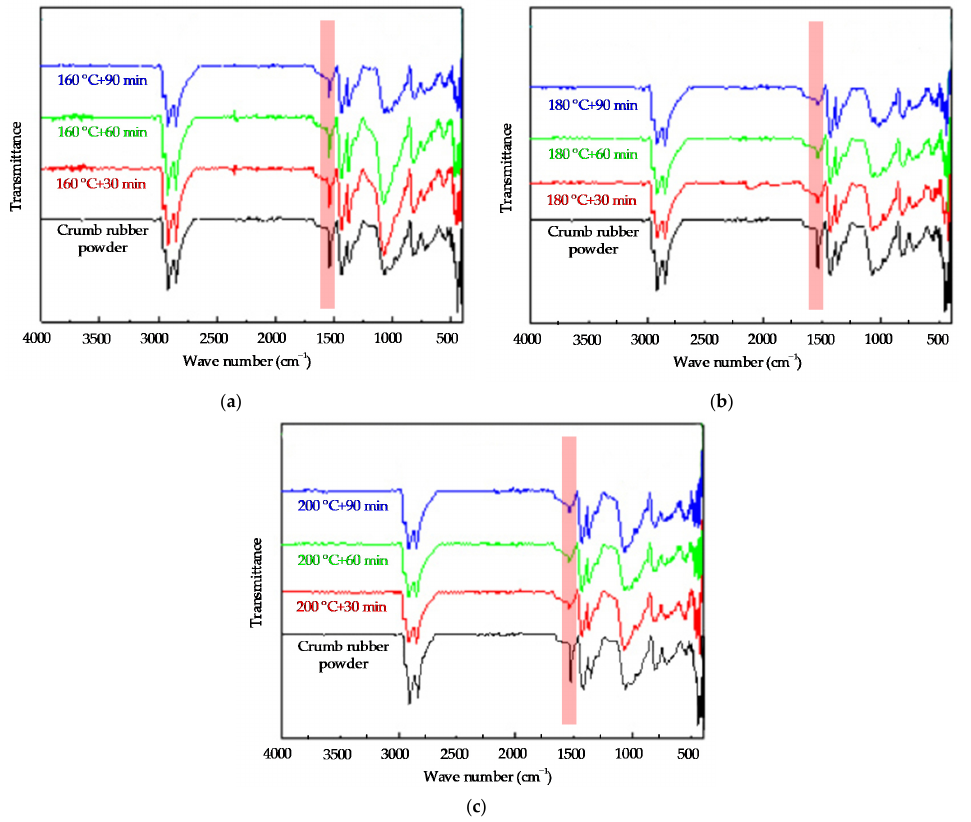
Figure 6. The infrared spectrum of the crumb rubber by activated by heat treatment at different durations: ( a ) 160 °C; ( b ) 180 °C; and ( c ) 200 °C.